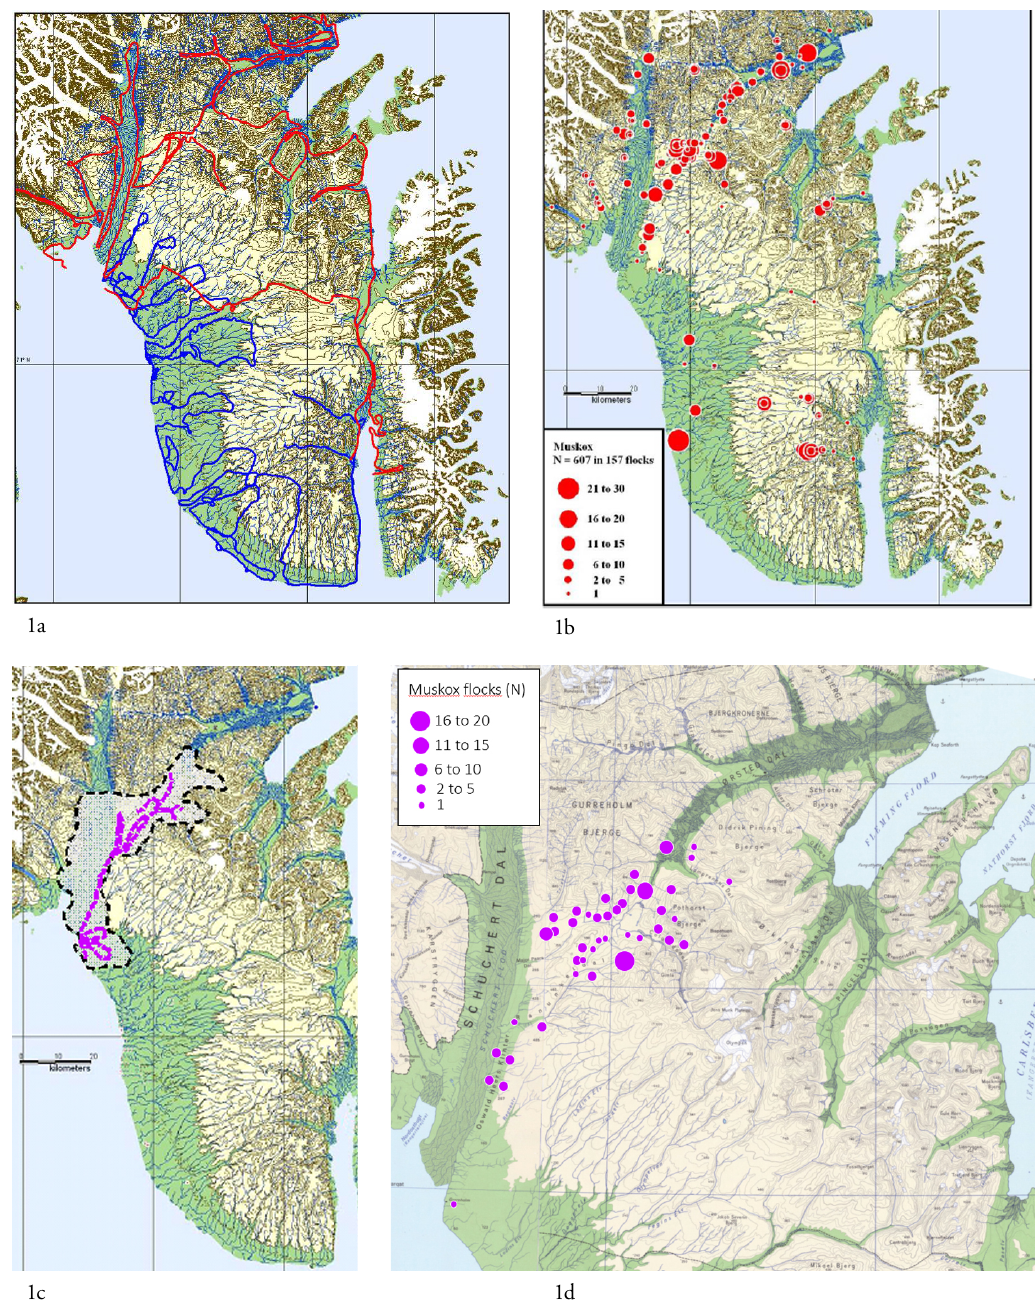
Figure 1. Jameson Land region, illustrating routes flown (a) and observed muskox locations and group sizes (b) recorded during unsystematic aerial bird survey, July 2008 (from Glahder et al., 2010). July 2016 walking routes and censused area (c) and observed muskox locations and group sizes